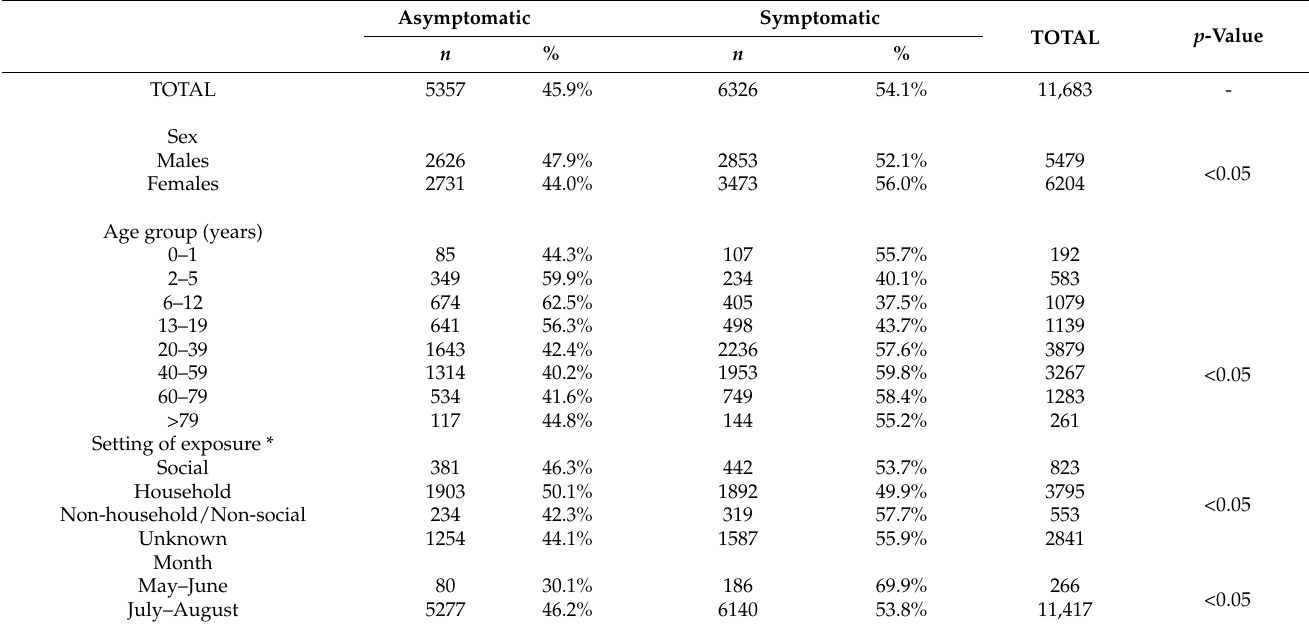
Table 2. Demographic factors of symptom development among secondary cases reported at the time of case epidemiological interview.